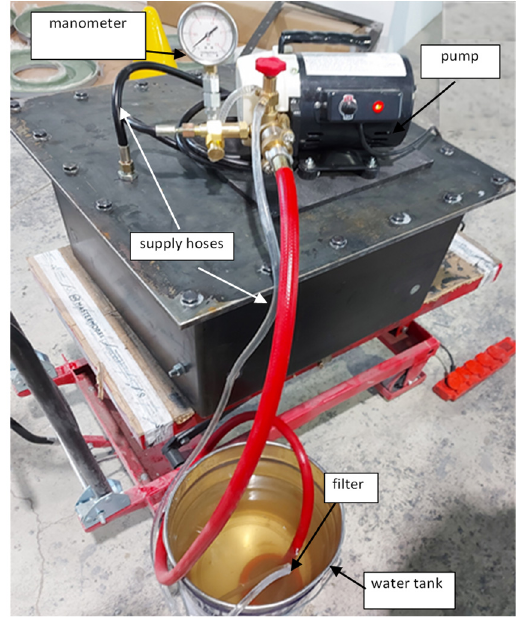
Figure 19. Pressure test